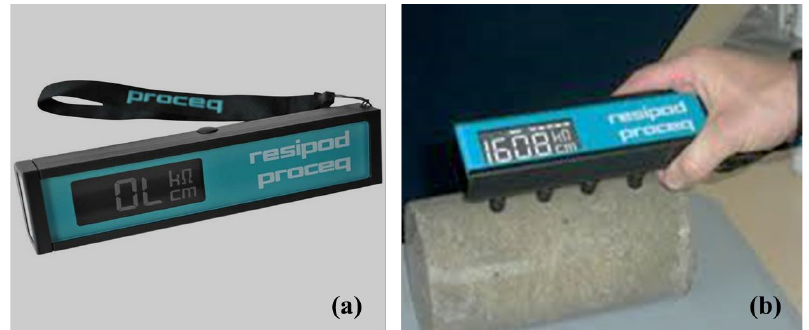
Figure 4. ( a ) RESIPOD electrical resistivity apparatus ( b ) Test setup to calculate electrical resistiv- ity.